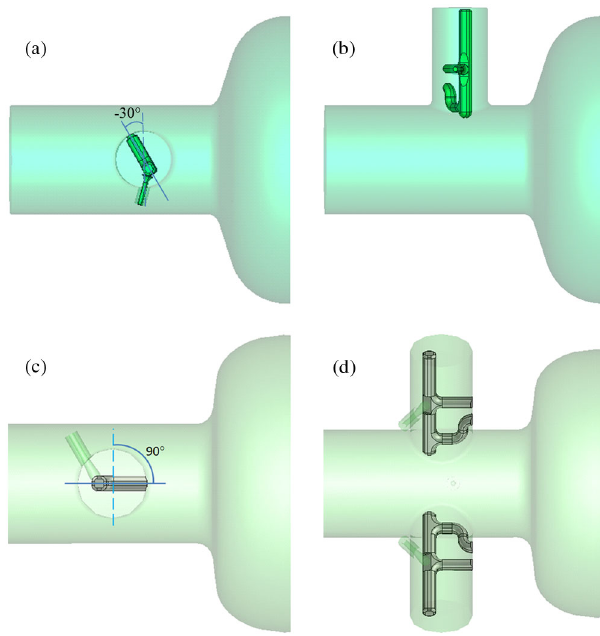
FIG. 8. Comparison of HOM couplers in ILC cavity (a),(b) and in CEBAF 12 Gev upgrade cavity (c),(d). The angle between HOM coupler plane and the plane vertical to the cavity axis is − 30 ° in ILC cavity and 90° in CEBAF cavity. The ILC cavity has two HOM couplers, one each at two end-groups with an angular displacement of 115° with respect to each other when viewed along the cavity axis direction. The CEBAF upgrade cavity has two HOM couplers, both at the same end-group with an angular displacement of 115° when viewed along the cavity axis direction.